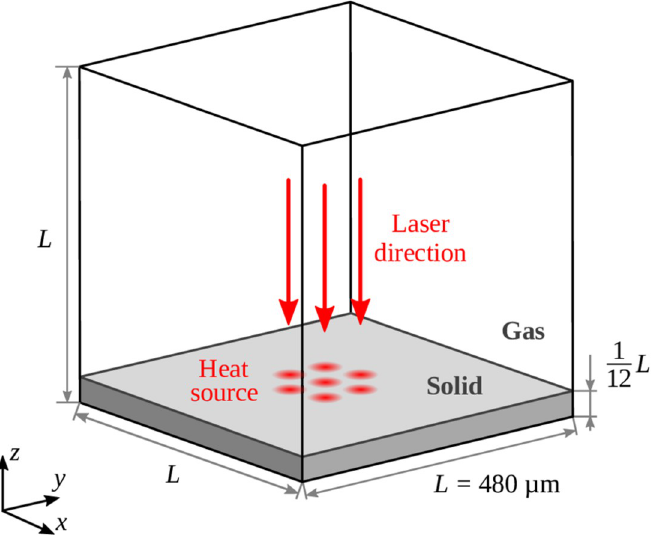
Fig 4. Size of the computational domain for the numerical simulations. Laser direction is indicated by red arrows and location of the volumetric laser heat source at the initial gas-solid interface.